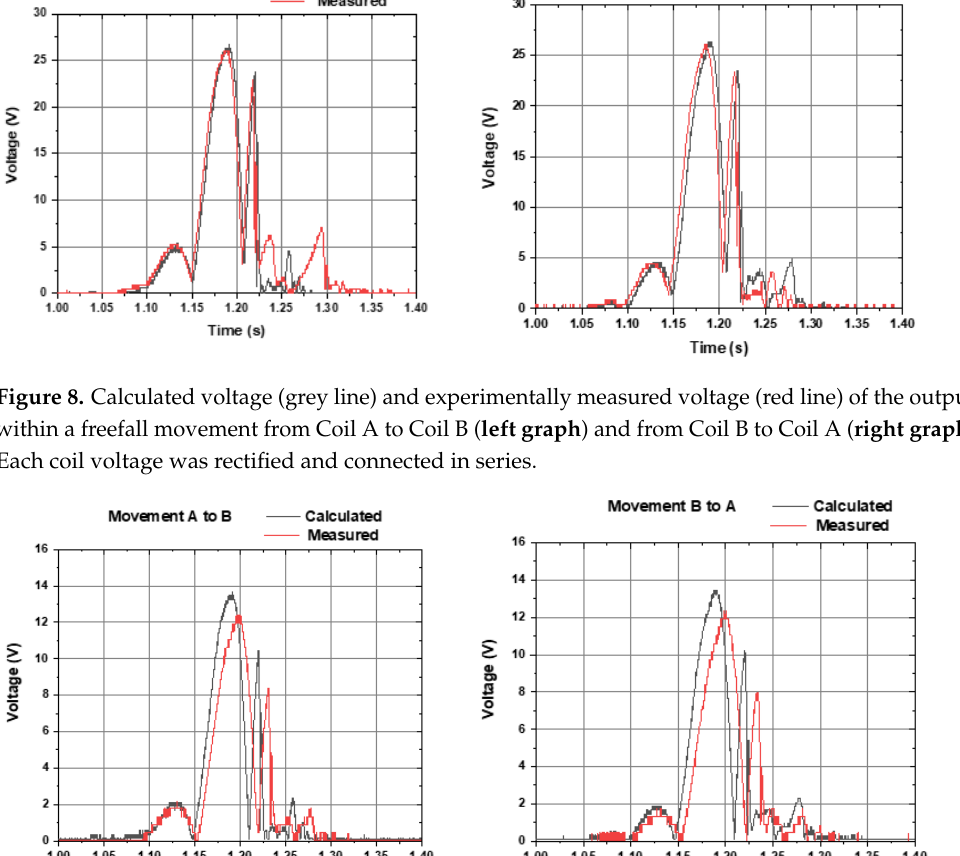
Figure 10 . Calculated theoretical voltage (grey line) and experimentally measured voltage (red line) of the output, within a freefall movement from Coil A to Coil B ( left graph ) and from Coil B to Coil A ( right graph ), with coils parallelized after rectification. 4.2. Comparison of Results By comparing the theoretical and experimental graphs from previous figures, the best connection configuration can be selected. Table 2 presents the maximum voltage, measured or calculated, from the presented four configurations, series or parallel, with rectification before or after a combination of coils and with movements in both directions.